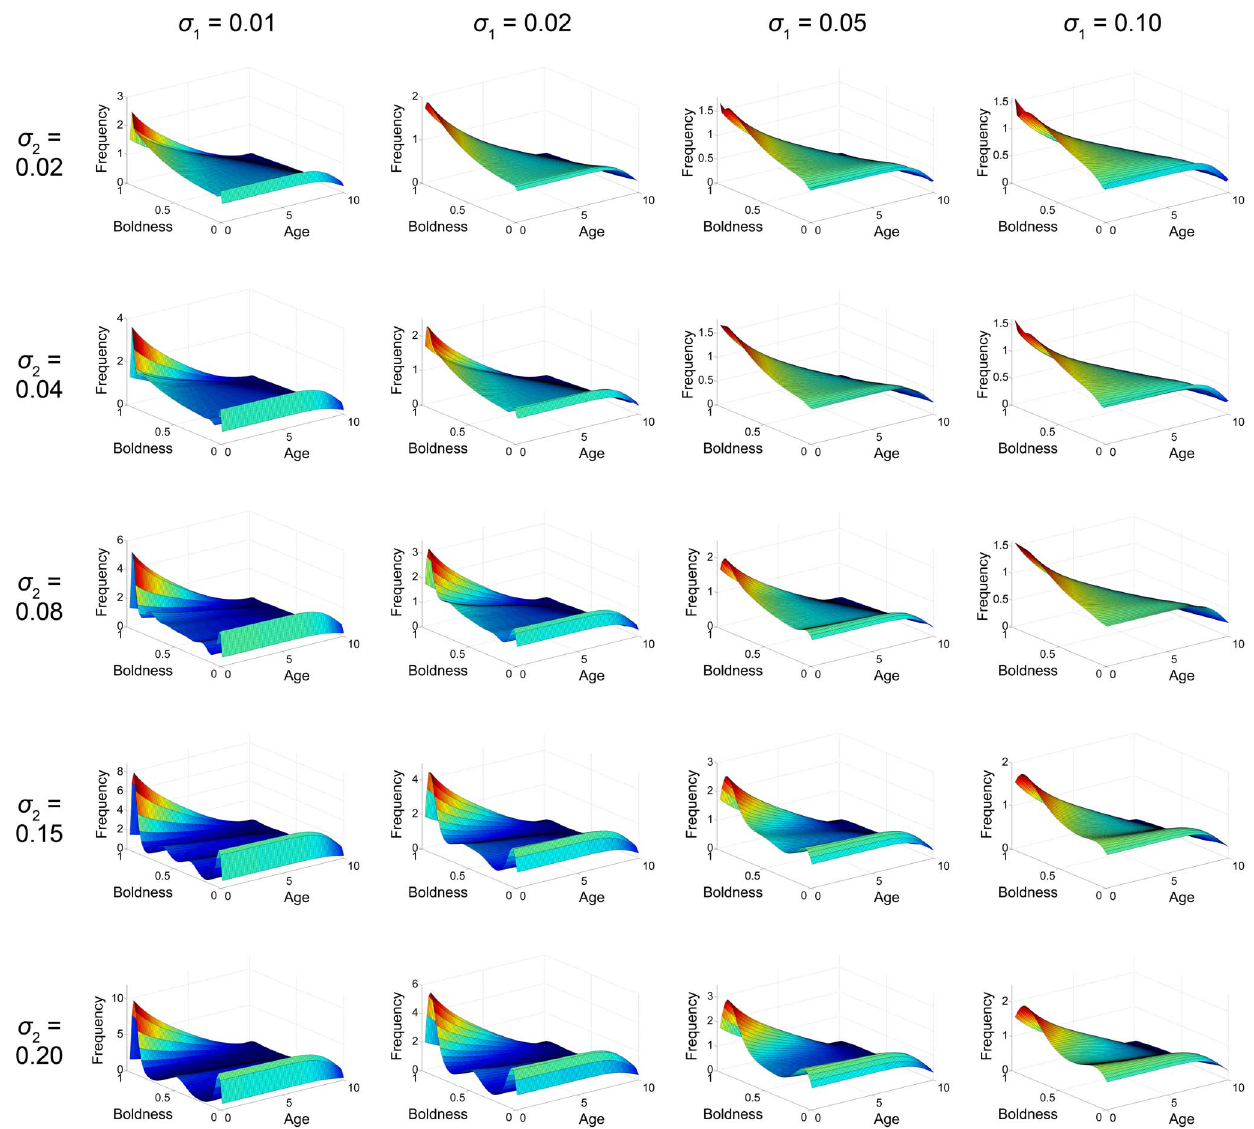
Figure 3. Comparison of solutions with different s 1 and s 2 . The system was numerically simulated using an Upwind scheme until the solution reached an equilibrium state. All cases reach equilibrium at approximately t ~ 300 , although the solution does not change substantially (minor shifts in distribution, but no big qualitative changes) after t ~ 140 . See also Figure 4.